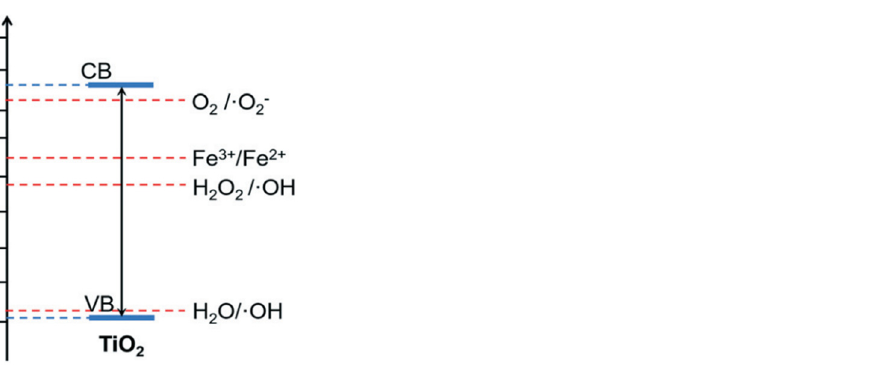
Figure 29. Potential redox for species generated in Fenton reaction [27]. Reproduced with permission from Zeng et al. Copyright © 2022 The Royal Society of Chemistry.